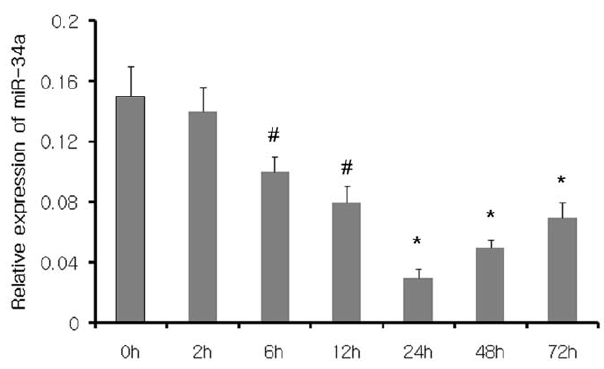
Figure 1. Hypoxia induces downregulation of miR-34a expres- sion in HK2 cells. qRT-PCR analysis of miR-34a expression after 2, 6, 12, 24, 48 and 72 h of hypoxia and the relative amount of miRNA was normalized to U6 snRNA. Triplicate assays were performed for each RNA sample. # p , 0.05 and *p , 0.01 compared with normoxic controls.